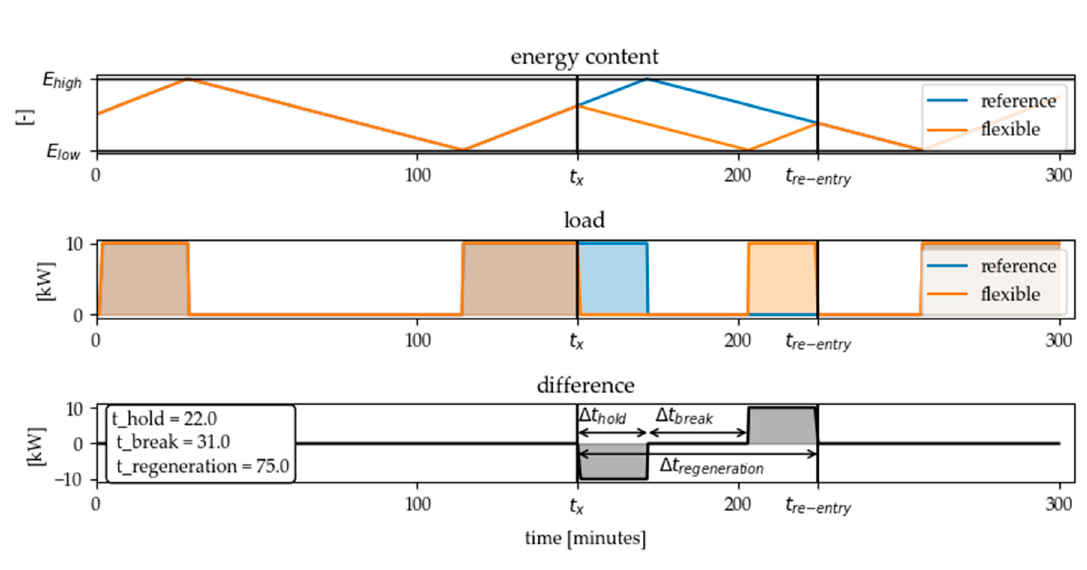
Figure 8. By defining the re-entry-point t re − entry in the reference load profile (intersection of the reference load and the flexible load profile), a defined load shift can be achieved. This can be quantified by the standard key indicators for flexibility products.